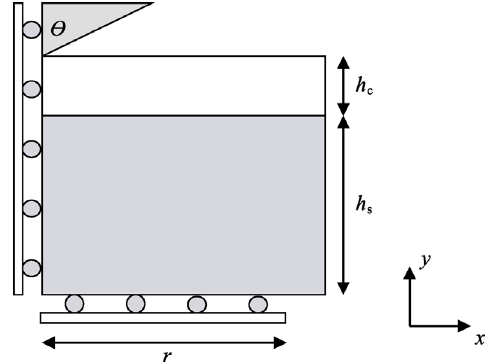
Fig. 5 Schematic of the 2D axisymmetric FEM